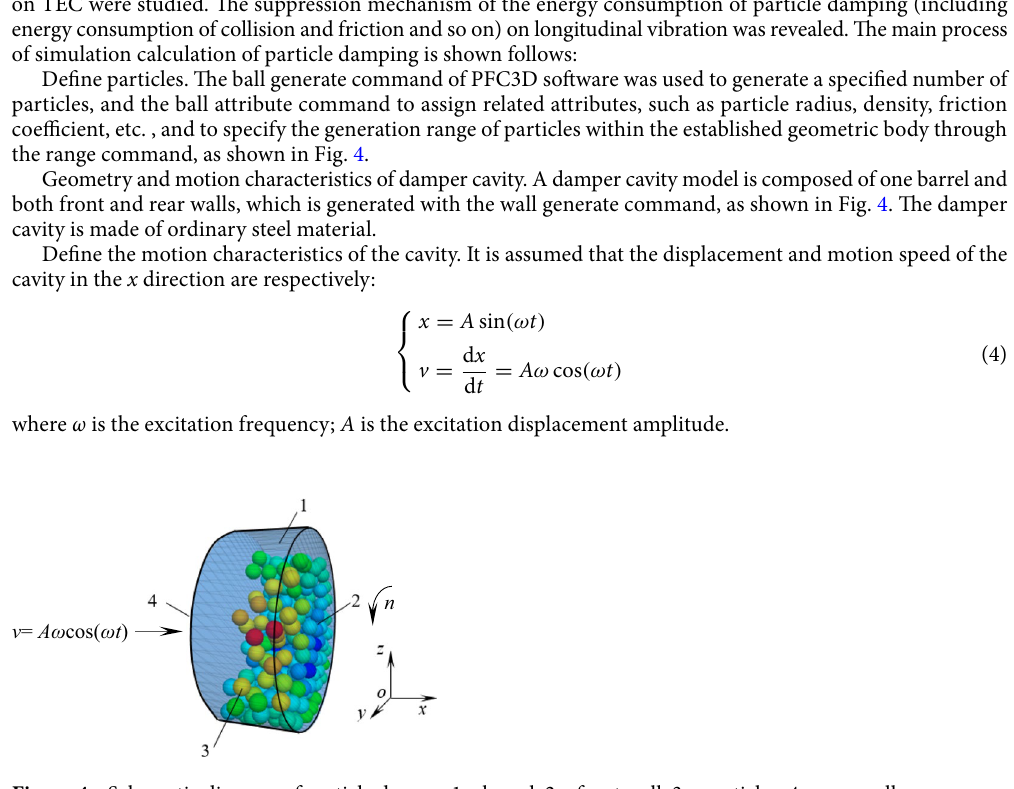
Figure 4. Schematic diagram of particle damper 1—barrel; 2—front wall; 3—particles; 4—rear